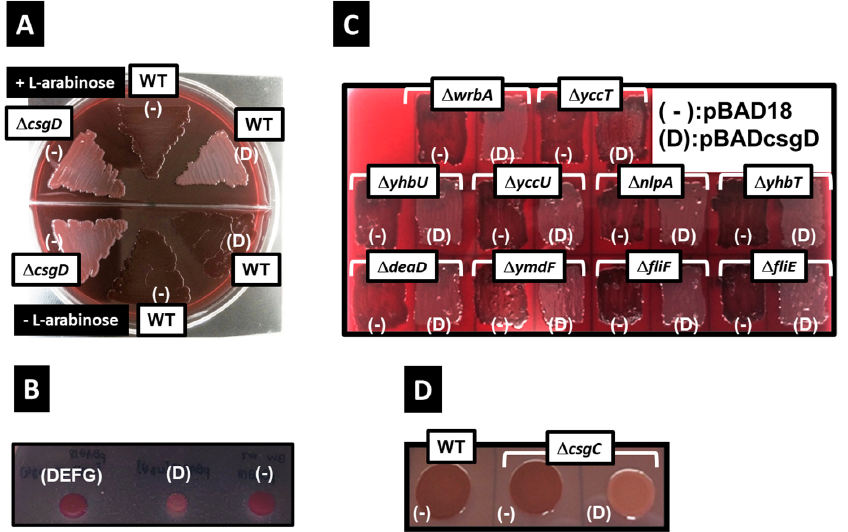
Figure 1. Inhibition of curli fimbriae formation via CsgD overexpression. Curli fimbriae formation was assessed through Congo red staining. ( A ) A csgD deletion strain ( Δ csgD ) transformed with the control vector pBAD18 ( − ) and wild ‐ type (WT) strain transformed with pBAD18 ( − ) or pBADcsgD (D) were plated and incubated on a Congo red YESCA plate at 28 °C for 2 days in the presence (upper half) or absence (lower half) of 0.2% arabinose. ( B ) A wild ‐ type strain (WT) transformed with pBADcsgDEFG (DEFG), pBADcsgD (D), or pBAD18 ( − ) were incubated on a Cong red YESCA plate at 28 °C for 2 days in the presence of 0.2% arabinose. ( C ) Effects of CsgD overexpression on curli fimbriae formation in strains deficient for CsgD target genes. Ten individual strains were generated by deleting CsgD targets ( wrbA , yccT , yhbU , yccU , nlpA , yhbT , deaD , ymdF , fliF, and fliE ). The control vector pBAD18 ( − ) or pBADcsgD (D) were introduced in each deletion strain. Cells were plated and incubated on a Congo red YESCA plate in the presence of 0.2% arabinose at 28 °C for 2 days. ( D ) Effect of CsgD overexpression on curli fimbriae formation in the CsgC deletion strain. A WT transformed with the control vector pBAD18 ( − ) and csgD deletion strains ( Δ csgD ) transformed with pBAD18 ( − ) or pBADcsgD (D) were plated and incubated on a Congo red YESCA plate in the presence of 0.2% arabinose at 28 °C for 2 days.